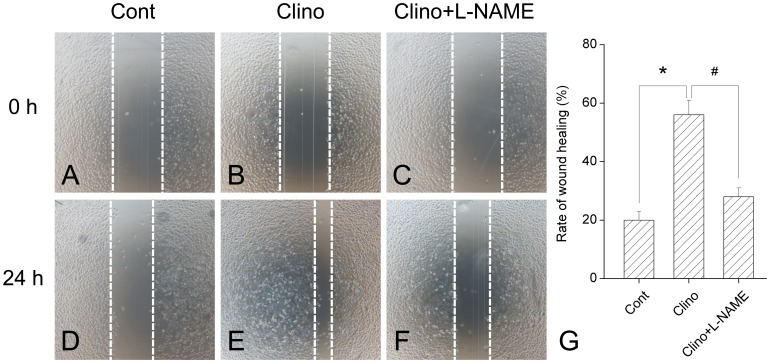
L-NAME inhibits simulated microgravity-induced HUVEC-C migration.An in vitro wound-healing assay was performed to evaluate the migration abilities of HUVEC-C treated with clinorotation in the absence or presence of L-NAME. The confluent HUVEC-C were wounded by scraping with a yellow tip. The cells were (A, B, C) washed, and then (D, E, F) incubated 24 h with fresh medium. The migration ability was determined by measuring the width of each denuded area and by calculating through the formula: 100%−(width 24 h/width 0 h) × 100%. (G): Result depicted that simulated microgravity caused an obviously increase in wound healing which was abrogated by L-NAME treatment. The data represent mean ± SD of three independent experiments. *
P<0.05 versus control group; #
P<0.05 versus clinorotation group.